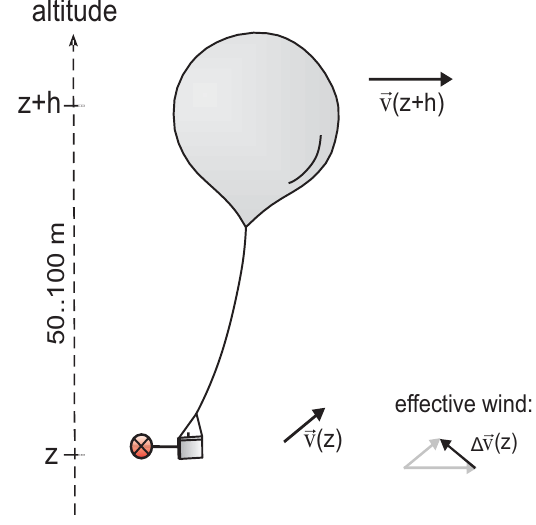
Fig. 2. Schematic drawing of the principle of balloon-borne wind turbulence